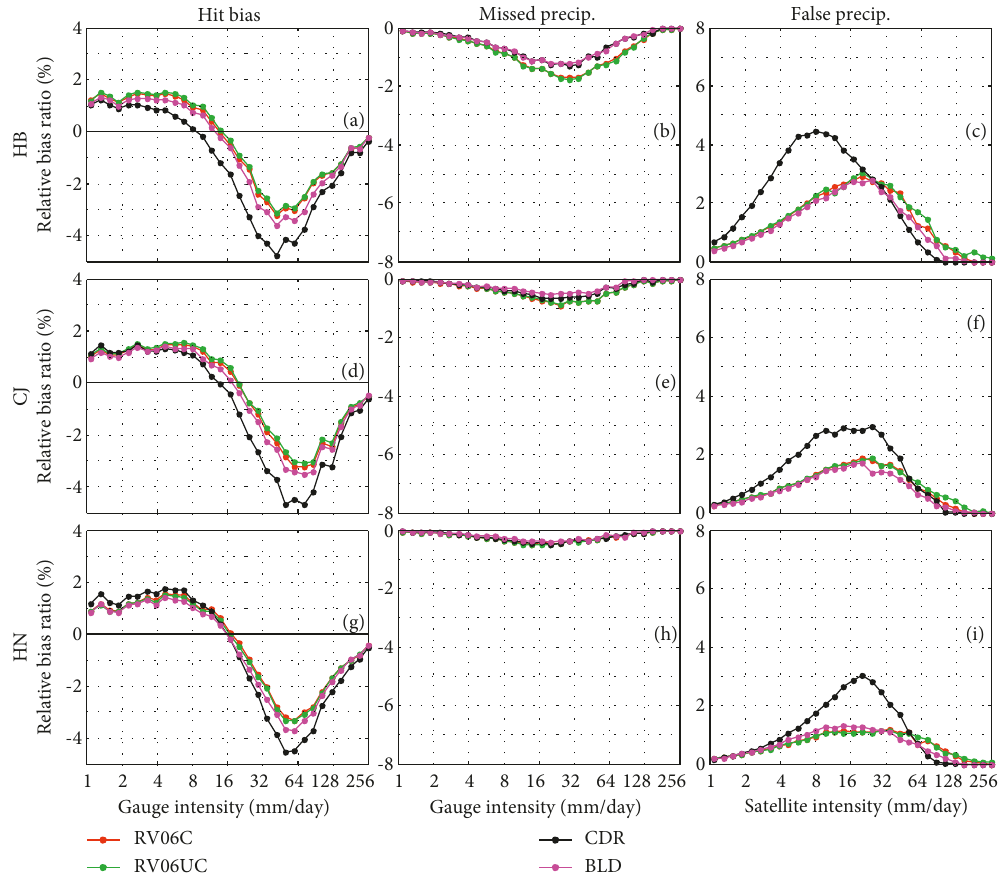
Figure 20: Same as Figure 18 except for the HB, CJ, and HN